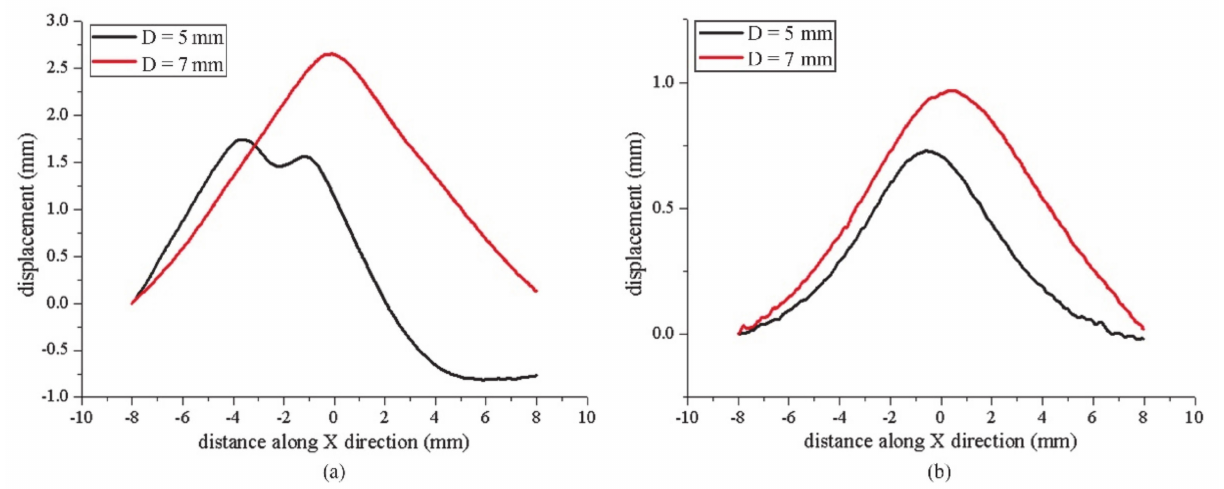
Figure 3. ( a ) The outline of targets with 0.08 mm thickness. ( b ) The outline of targets with 0.3 mm thickness.